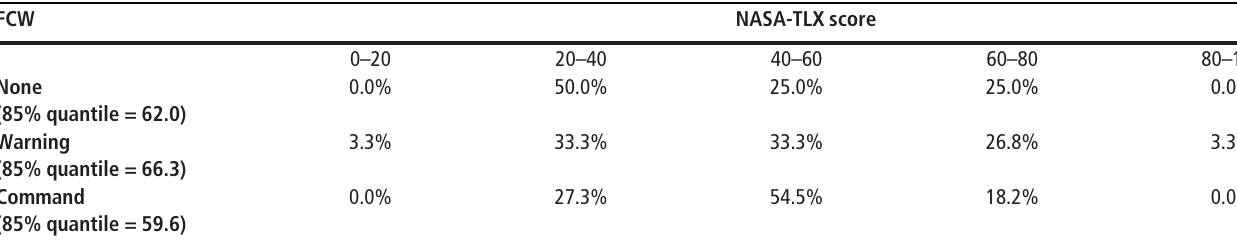
Table 7 Range of mental workload evaluated by NASA-TLX in three FCW